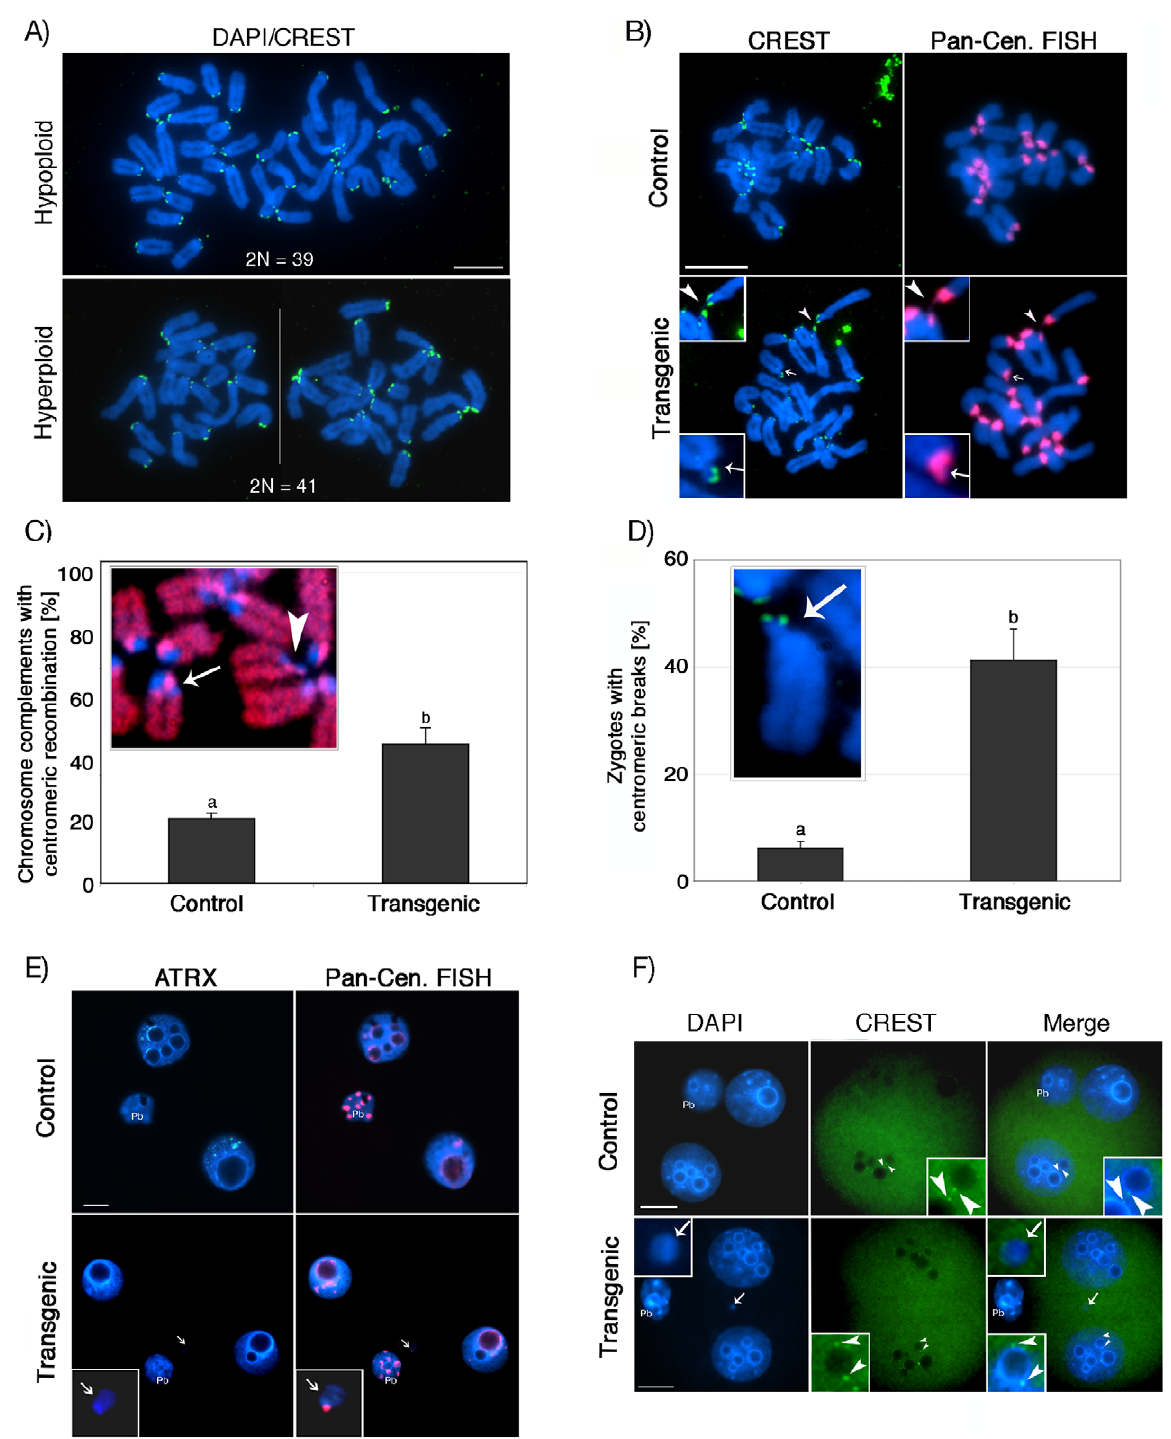
Figure 7. Centromere instability and micronuclei formation following fertilization of ATRX-deficient oocytes. ( A ) Transmission of aneuploidy from the oocyte to the pre-implantation embryo in chromosome spreads obtained from transgenic zygotes analyzed by CREST (green) immunochemistry. Upper panel: transgenic zygote spread with hypoploid karyotype (2N=39); lower panel: hyperploid karyotype showing 41 chromosomes (micrographs of chromosome complements of this zygote were taken individually (white line) to display at a comparable magnification with the panel above). ( B ) Partial chromosome spreads from zygotes undergoing the first mitotic division. Chromosomes were immunostained with CREST (green) and subsequently subjected to fluorescence in situ hybridization using a pan-centromeric DNA probe (red). Transgenic zygotes frequently presented chromosomal breaks at pericentric heterochromatin as indicated by detachment of a chromosomal fragment exhibiting a CREST signal and presence of major satellite DNA (red) at the proximal as well as at the distal fragment (arrow, right inset). Note that satellite DNA sequences in some chromosomes exhibit excessive stretching (arrowhead). ( C ) High incidence ( P , 0.005) of illegitimate centromere mitotic recombination in transgenic parthenogenetic zygotes as indicated by changes in lateral asymmetry of major satellite sequences (arrow). A